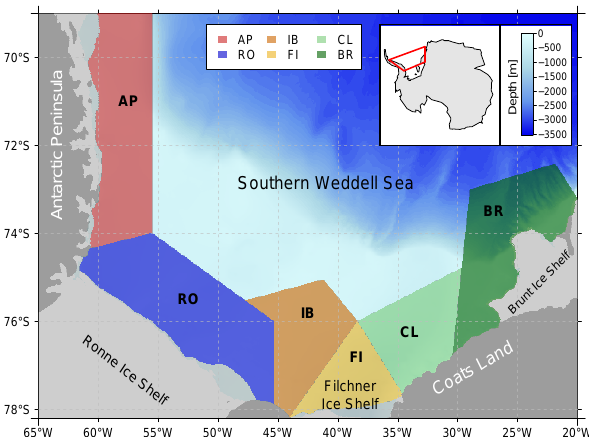
Figure 1. Sketch of the study area in the southern Weddell Sea with all six investigated subregions along the coast: Antarctic Penin- sula (AP), Ronne Ice Shelf (RO), the area around the grounded ice- berg A23A (IB), Filchner Ice Shelf (FI), Coats Land (CL), and the Brunt Ice Shelf (BR). Color shadings show the bathymetry based on Arndt